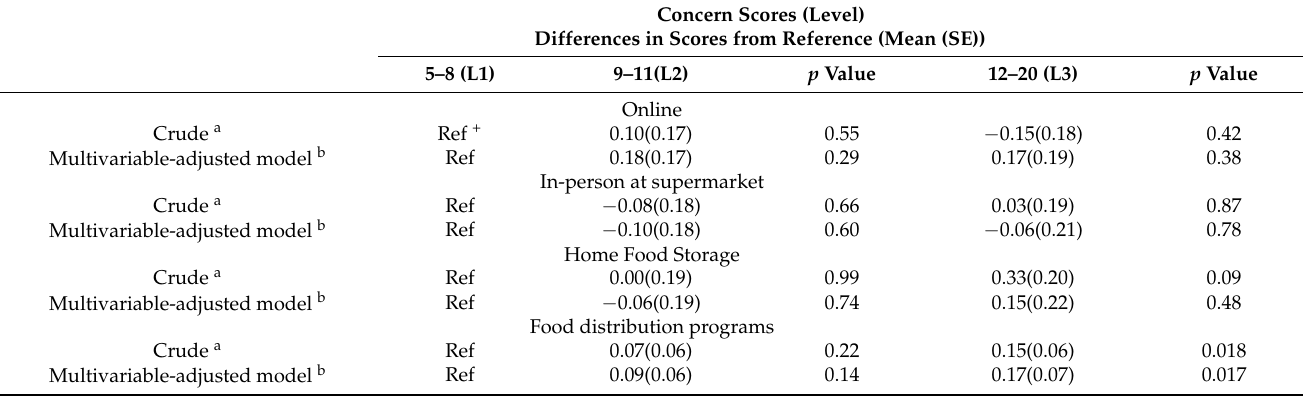
Table 2. Differences of Tendency of Grocery Shopping and Food Storage among Participants with Different Level of Food and Nutrition Related Concerns and Patterns.